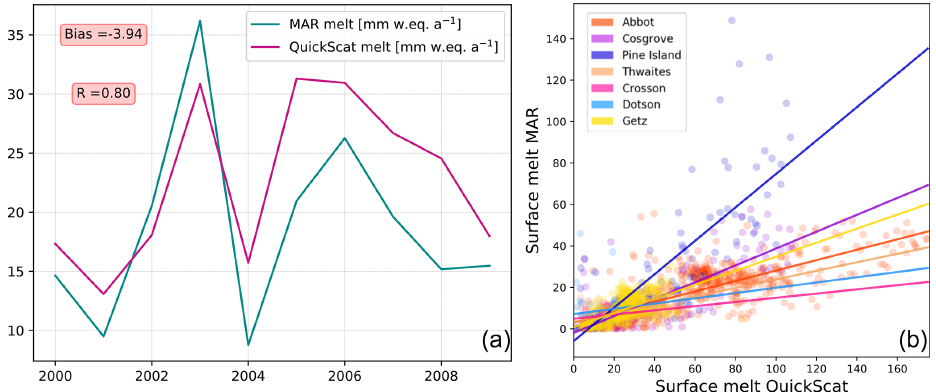
Figure 6. (a) Time series of surface melt rates in mean over the model domain derived from satellite data and simulated by MAR; years labeled on the X axis refer to the second year of a given austral summer (e.g., summer 1999–2000 is labeled 2000). (b) Surface melt modeled versus surface melt interpolated from satellite data (QuickSCAT) over drainage basins (only where surface melt > 0mmw.e.a − 1 ) and over the period